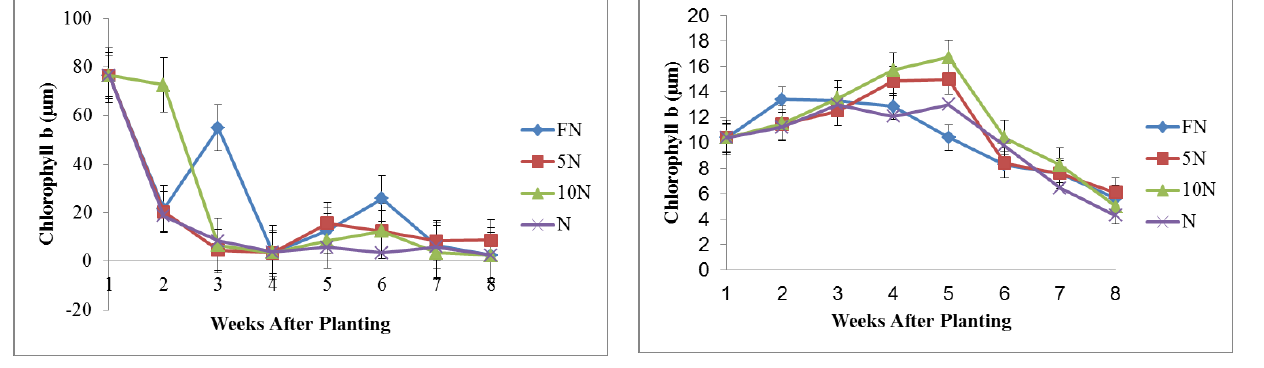
Fig. 2a. The effect of nitrogen nutritional stress on the chloro- phyll b accumulation of Vigna unguiculata measured at different periods